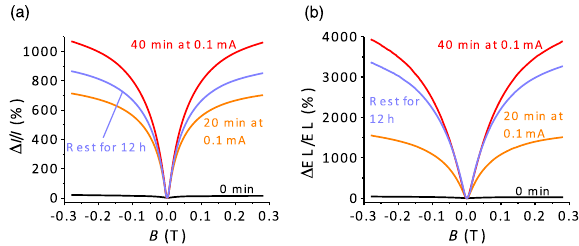
FIG. 10. (a),(b) Conditioning dependence of the device studied in Fig. 6. The blue line is for the optimally conditioned device after a rest period of 12 h and shows that the effect does not return to the pristine value.